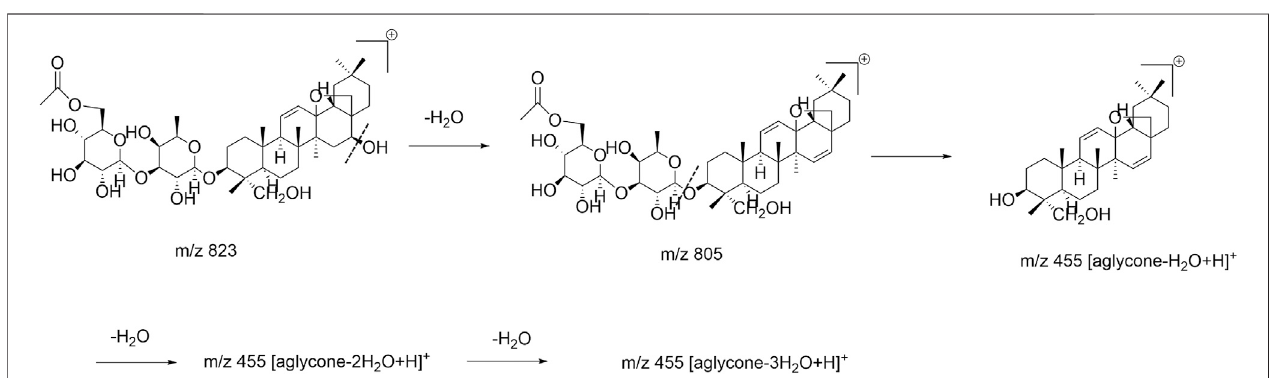
FIGURE 7 | Fragmentation pathway of 6 ″ - O -acetyl-SSa in the positive ion mode (ESI + ).